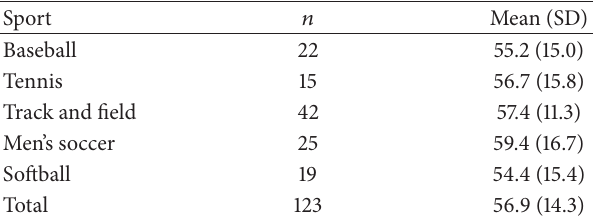
Table 1: Sports nutrition knowledge questionnaire mean scores by sport team.